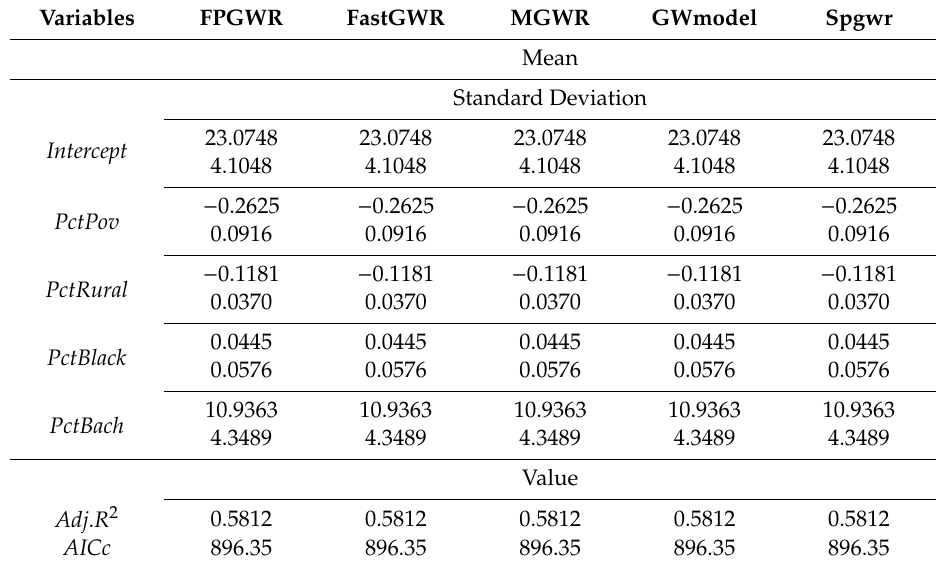
Table 5. Statistical results of local coe ffi cient estimates and regression estimates for five GWR packages.